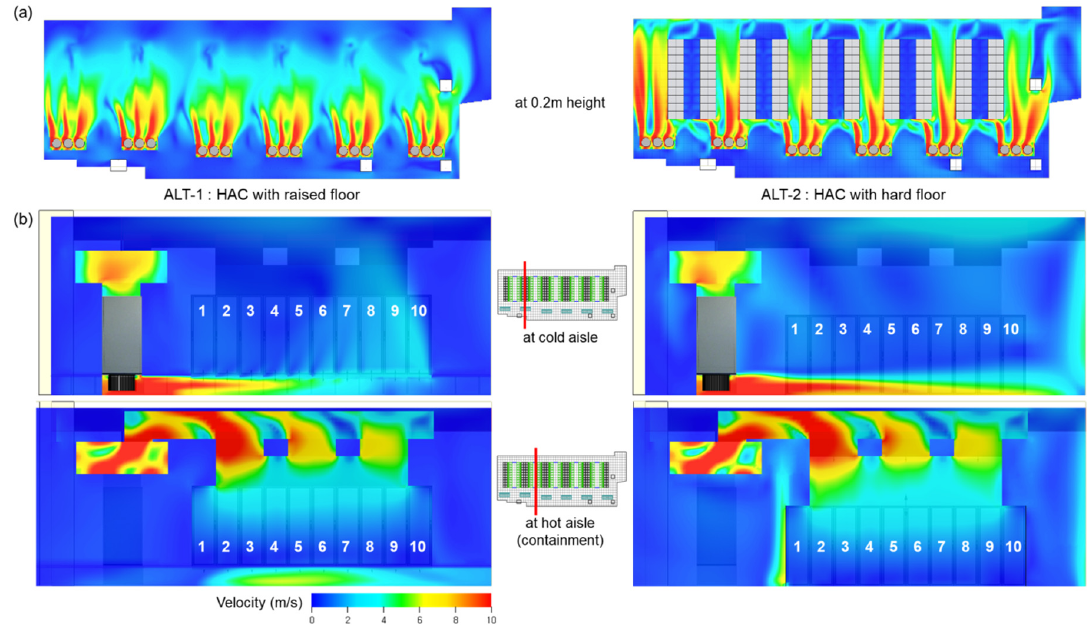
Figure 7. Contours of airflow velocity in normal cooling condition; ( a ) a horizontal section view and ( b ) a vertical section view.